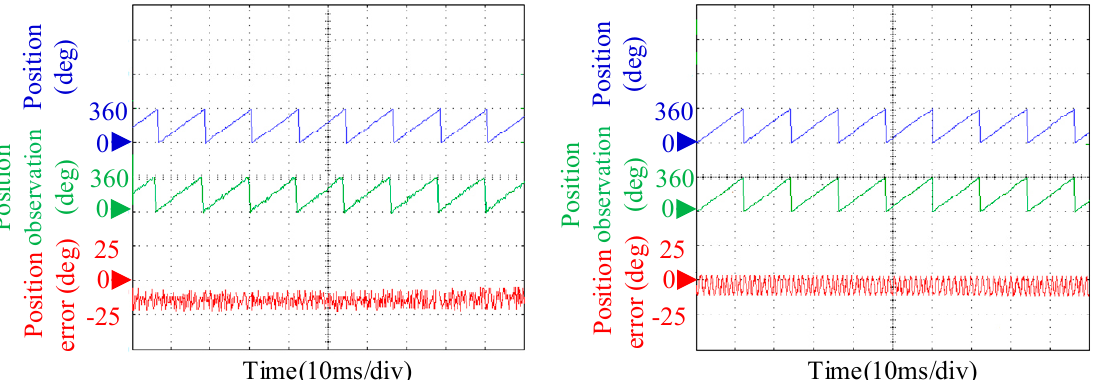
Figure 11. Experimental curves of the rotor position estimation.